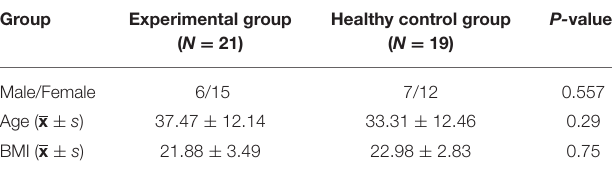
TABLE 1 | Comparison of sex, age, and BMI between the experimental group and the healthy control